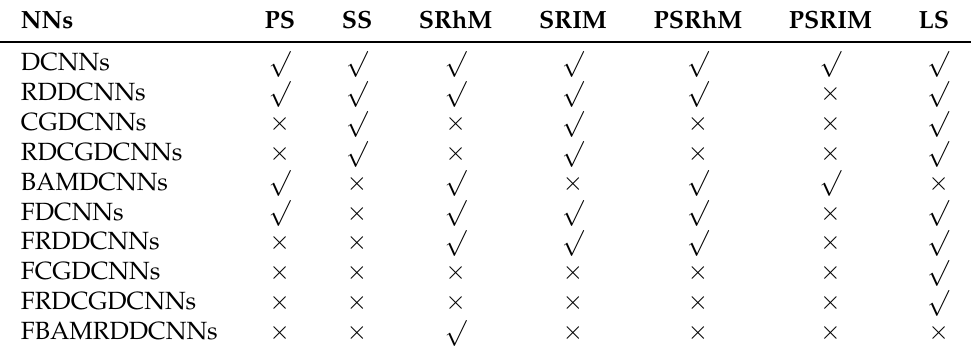
Table 1. Recent results on extended stability concepts applied to impulsive control